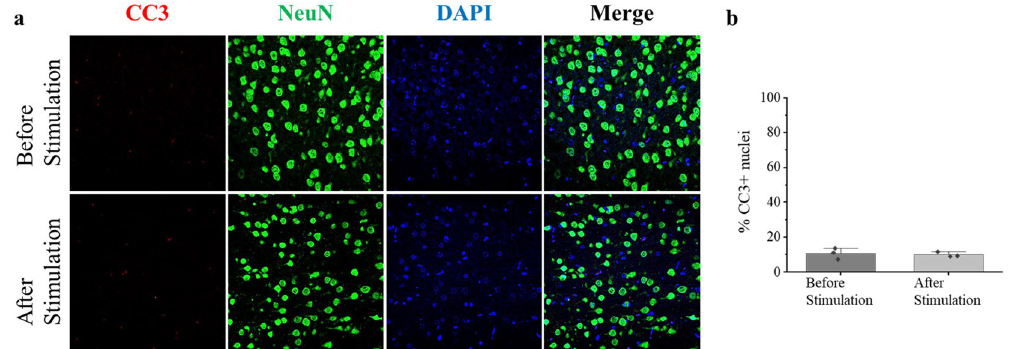
Figure 5. Immunohistochemistry staining before and after stimulation of the sham group. Original magnification, × 200. ( a ) Each of the images is representative of a field of immuno-stained cells. Each merged image includes the nuclear marker DAPI, CC3, and NeuN. Damage by the surgical process before stimulation and damage by the stimulation protocol was not confirmed. No significant changes such as cell damage indicating apoptosis or morphological changes of neuronal nuclei were observed in CC3 and NeuN. ( b ) The bar charts show the percentage of CC3-positive cells relative to the percentage of DAPI stained nuclei, in cells before and after stimulation. Each data point represents a biological replicate (n =